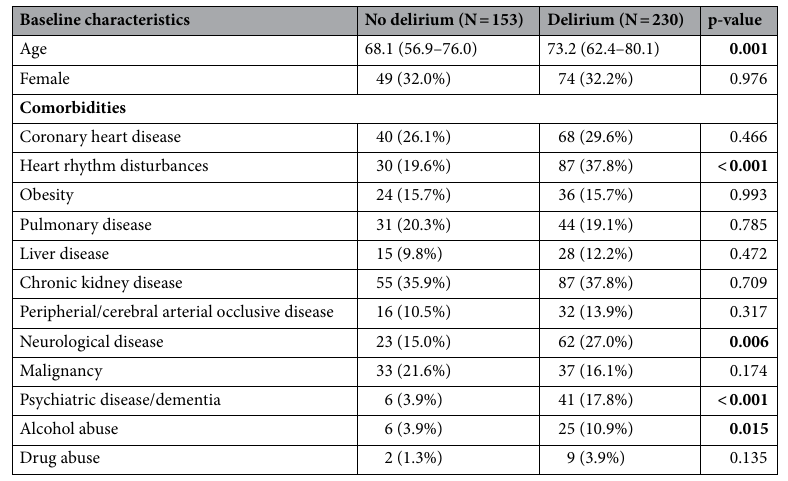
Table 2. Baseline characteristics of all patients with acute kidney injury. p value reported in bold if difference is significant (p < 0.05). Data are given as median and interquartile range (25th–75th) or number of patients (percent of all patients in group).